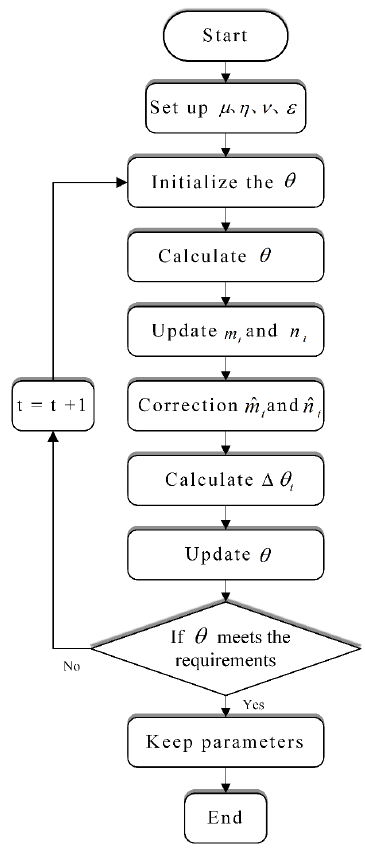
Figure 4. Adam algorithm